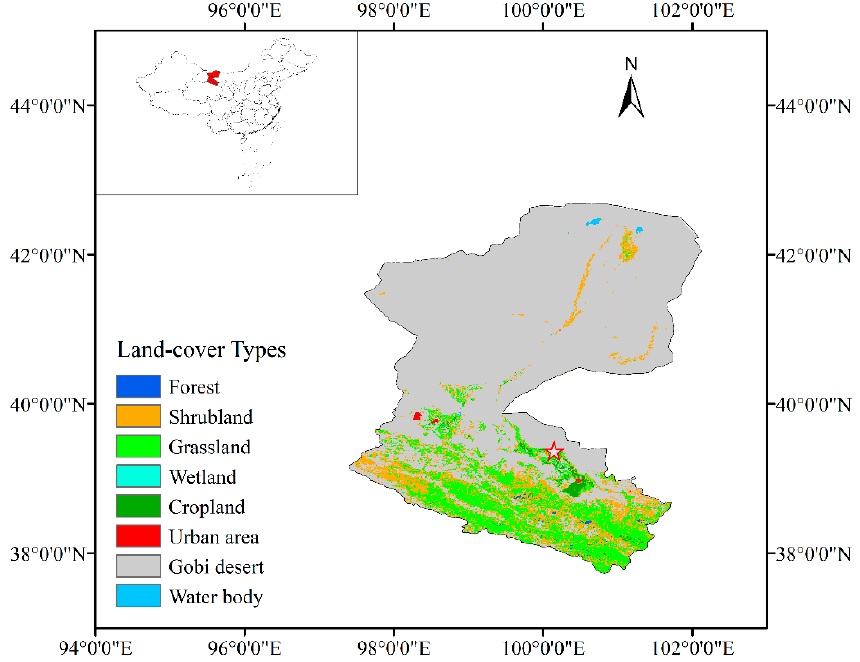
Figure 1. Map of the study area (the land-cover types were obtained from the Moderate Resolution Imaging Spectroradiometer (MODIS) 1 km IGBP land cover product (MOD12Q1; ftp://e0dps01u.ecs.nasa.gov/MOLT/MOD12Q1.004/2001.01.01/; accessed 08.07.2006)).